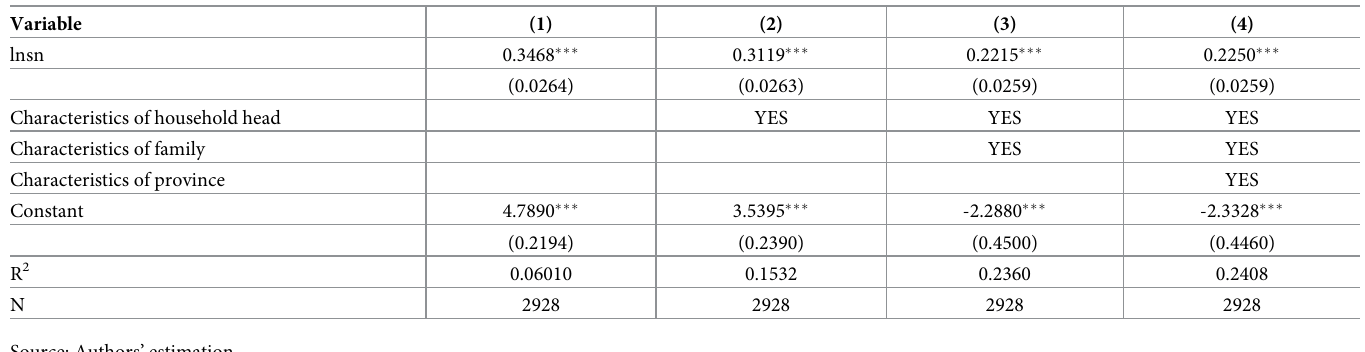
Table 5. Regression results of singular values of smoothing